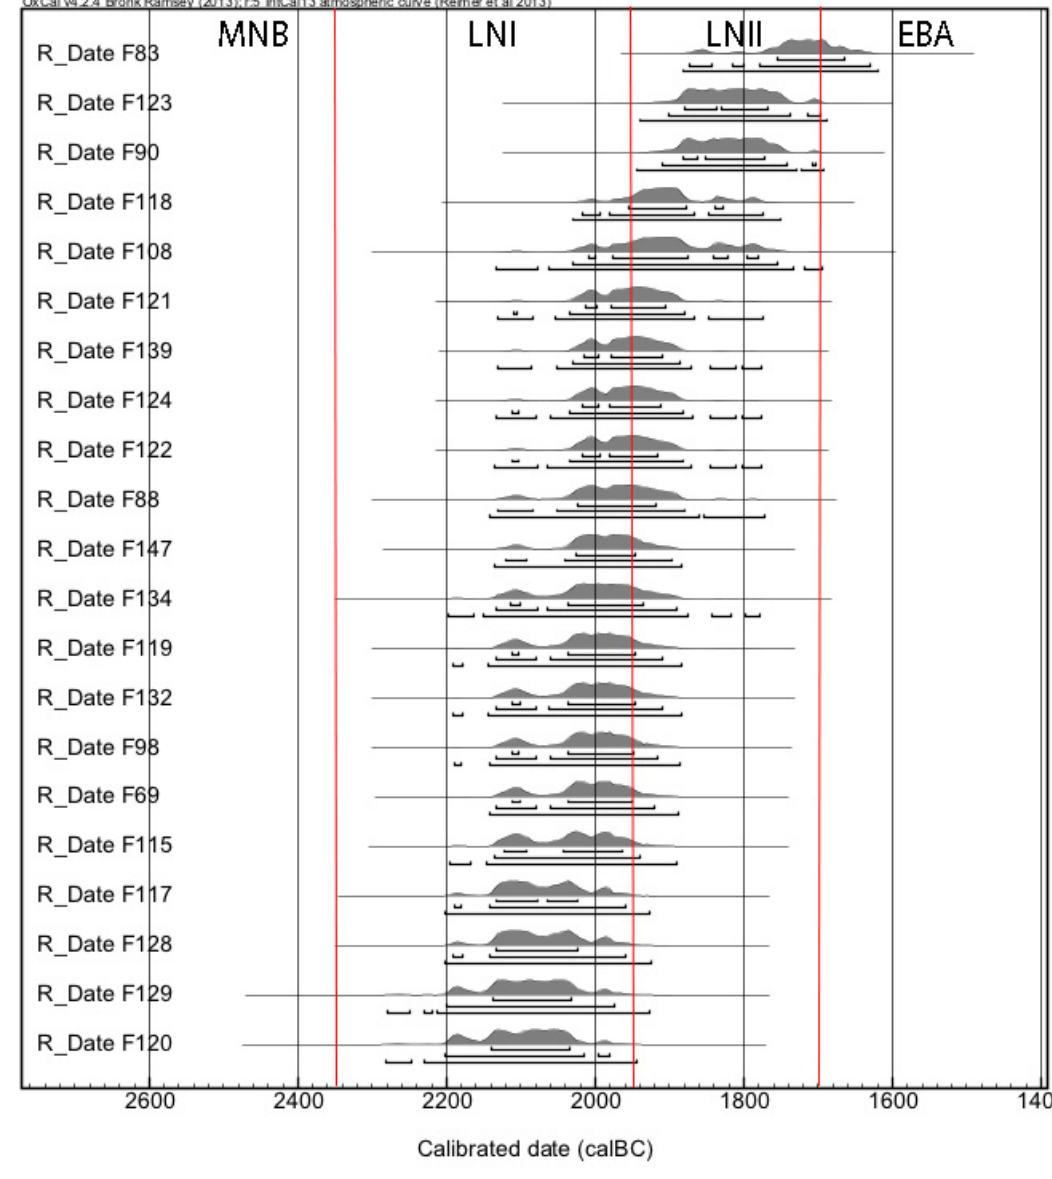
Figure 7. 14 C dates of the twenty individuals sampled from Falköping stad 5. OxCal v.4.2.4 Bronk Ramsey (2013); r:5 IntCal13 atmospheric curve (Reimer et al. 2015). Red lines mark the different periods: MNB: Middle Neolithic B, LNI: Late Neolithic I, LNII: Late Neolithic II and EBA: Early Bronze